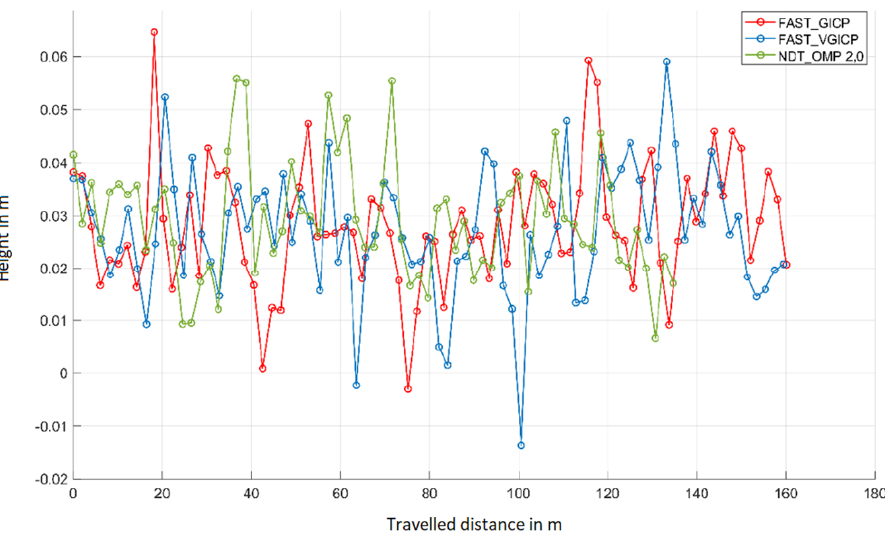
Figure 8. Height profile as a function of the distance covered in the corridor of the B-building of the Offenburg University of Applied Sciences with floor detection.